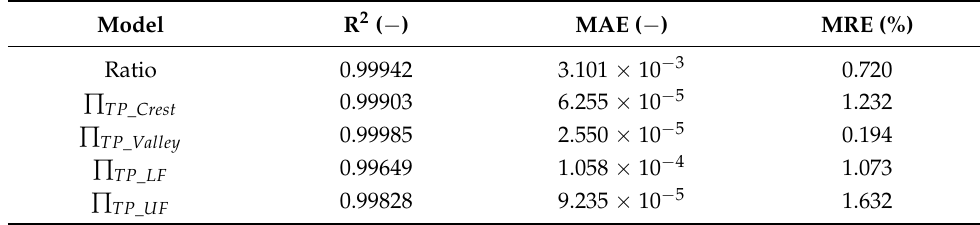
Table 7. Results of the error analysis of the wall thickness prediction